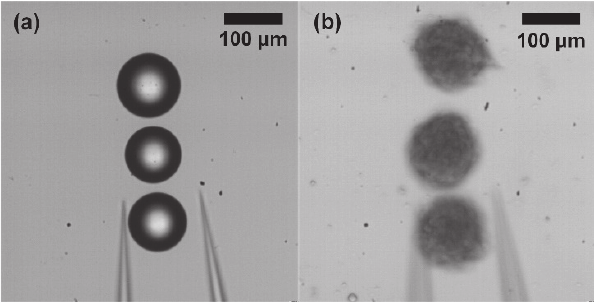
Figure 13. Results of the manipulation of three objects. ( a ) 85 (cid:442) 120 μ m microbeads, ( b ) 100 (cid:442) 120 μ m